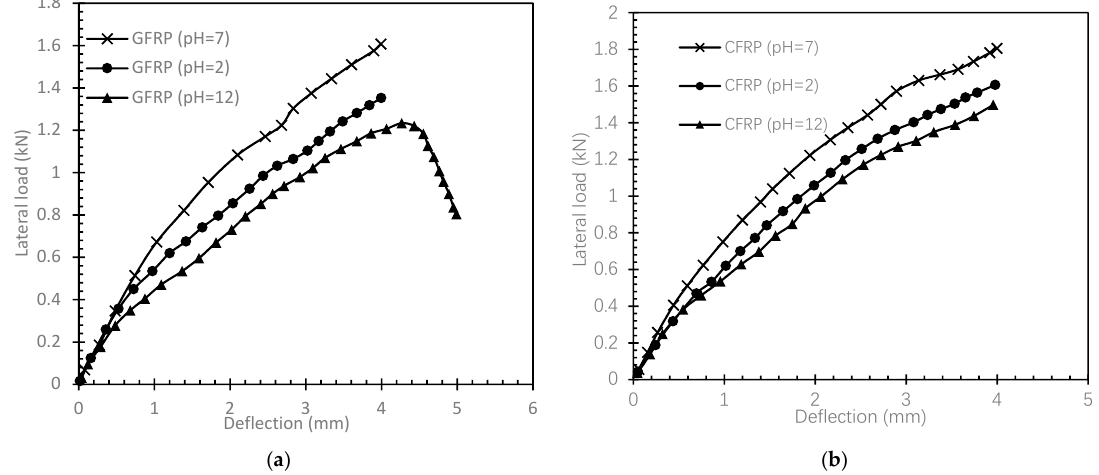
Figure 11. Aging effect on GFRP piles under a lateral load ( a ) and aging effect on CFRP piles under a lateral load ( b ).